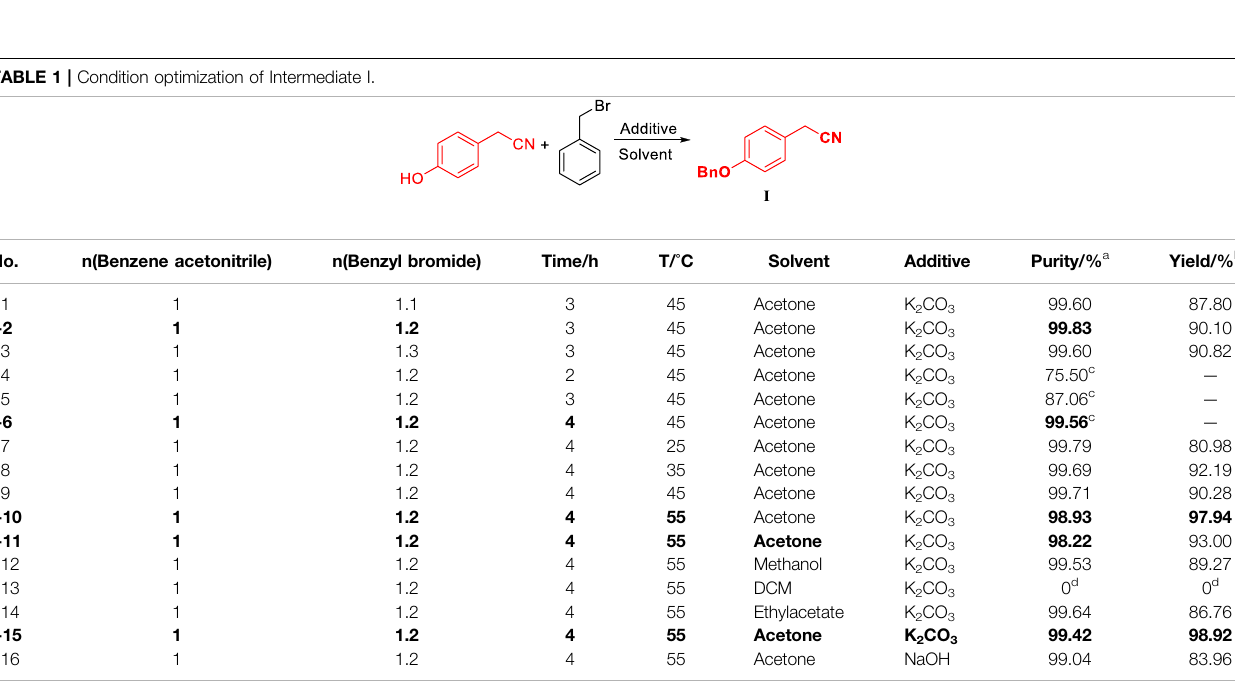
TABLE 1 | Condition optimization of Intermediate